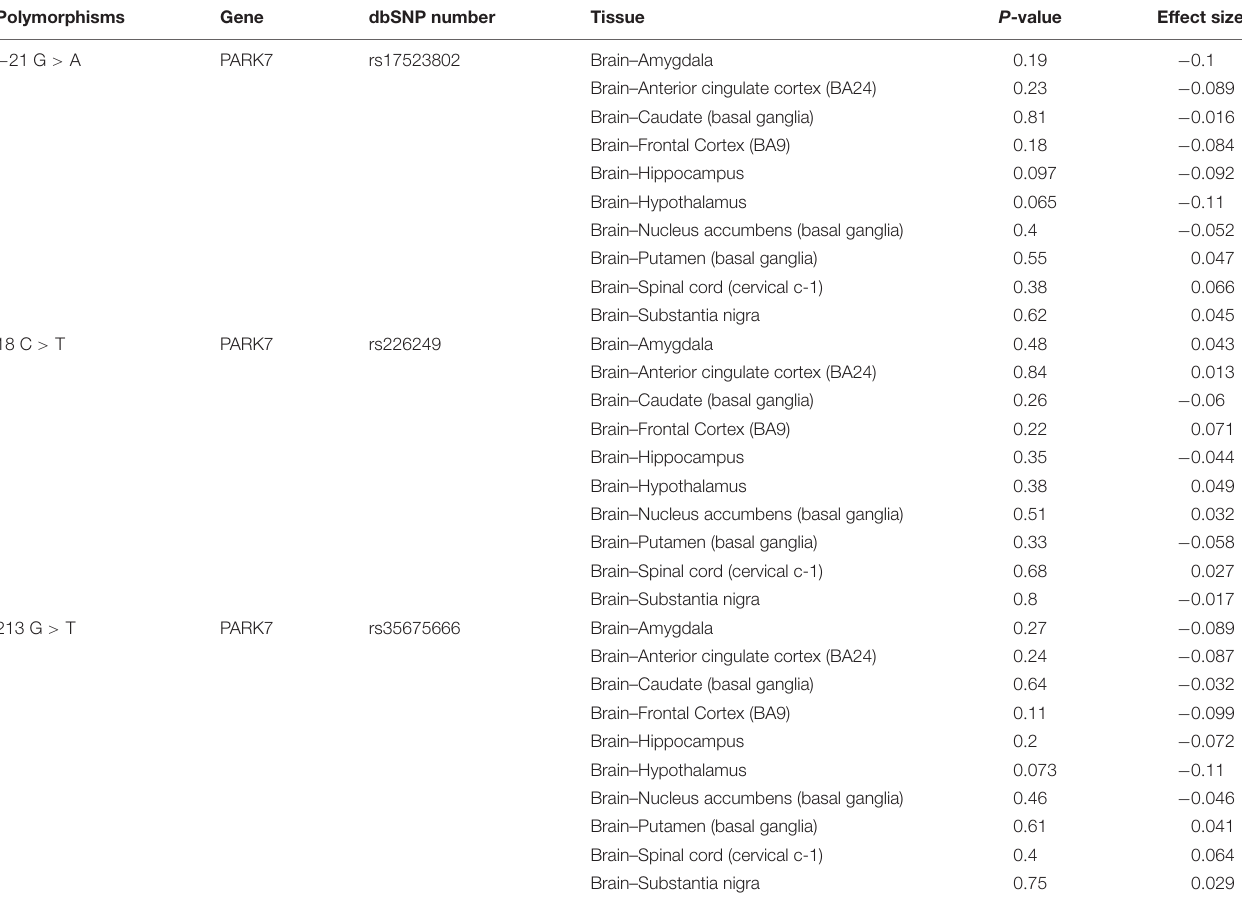
TABLE 7 | Effect of rs17523802, rs226249, and rs356756666 on DJ-1 mRNA expression in different regions of normal human